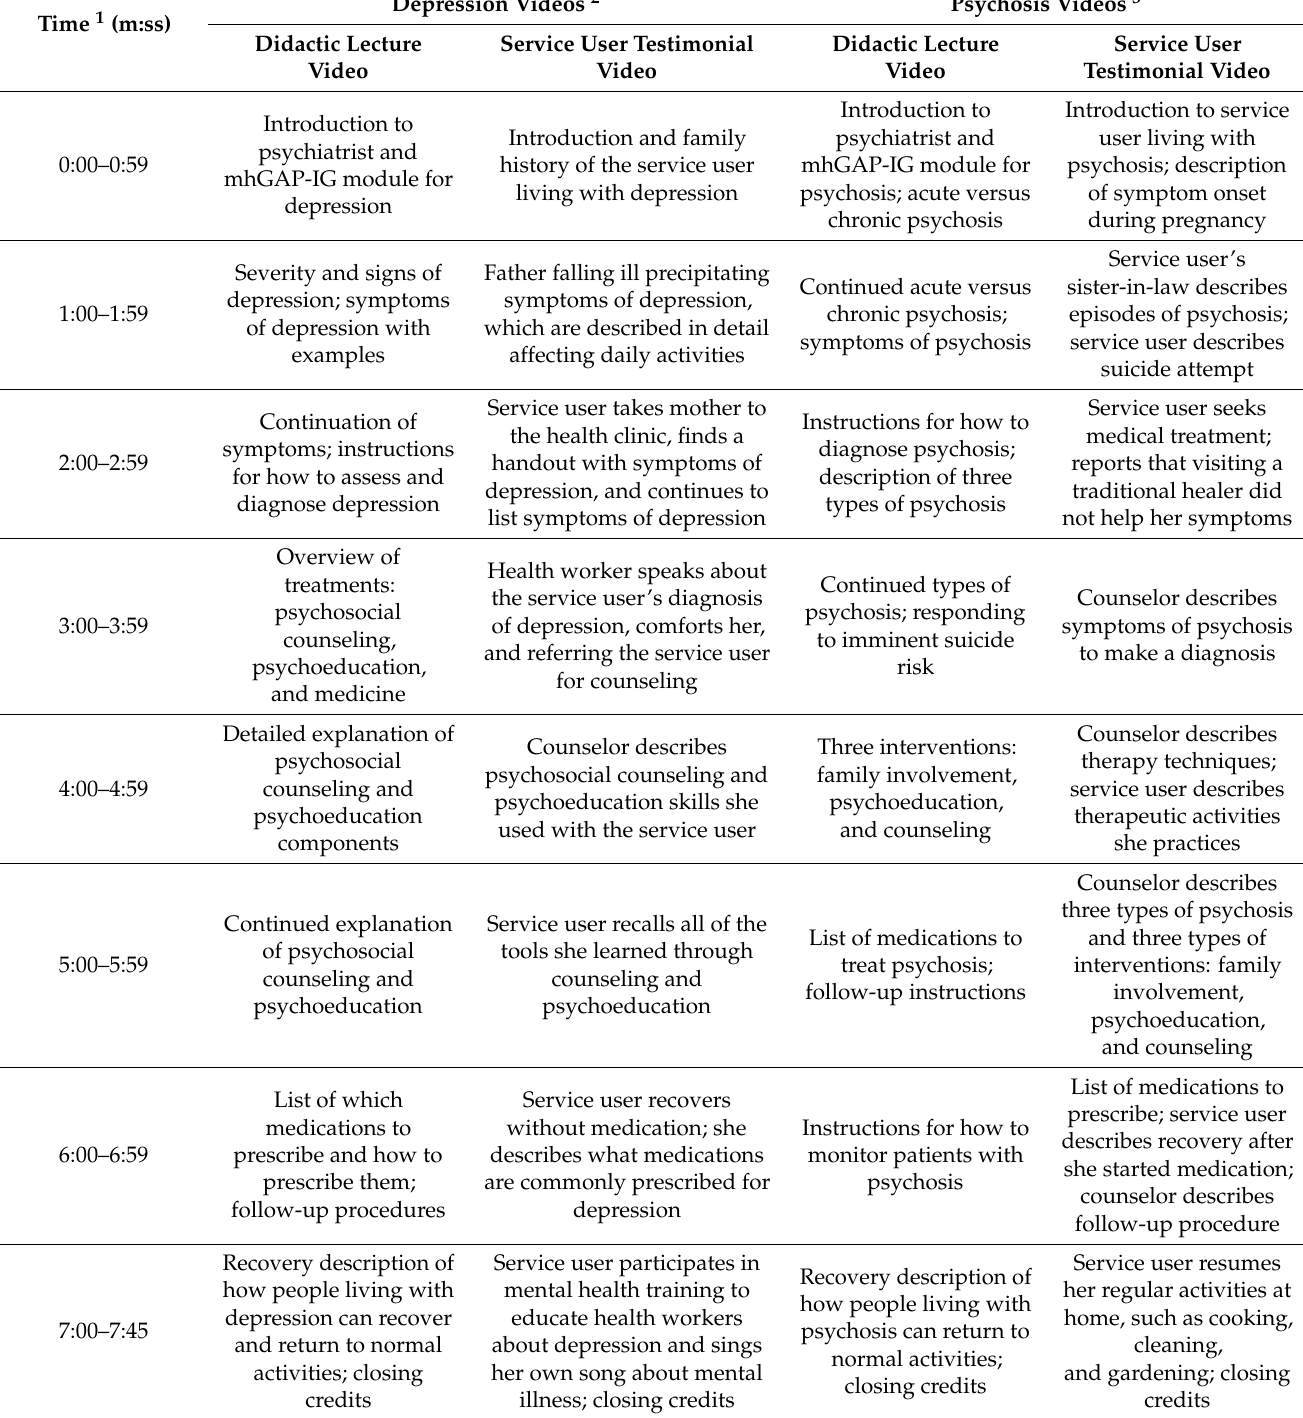
Table 1. Content of didactic and service user testimonial videos (8 min